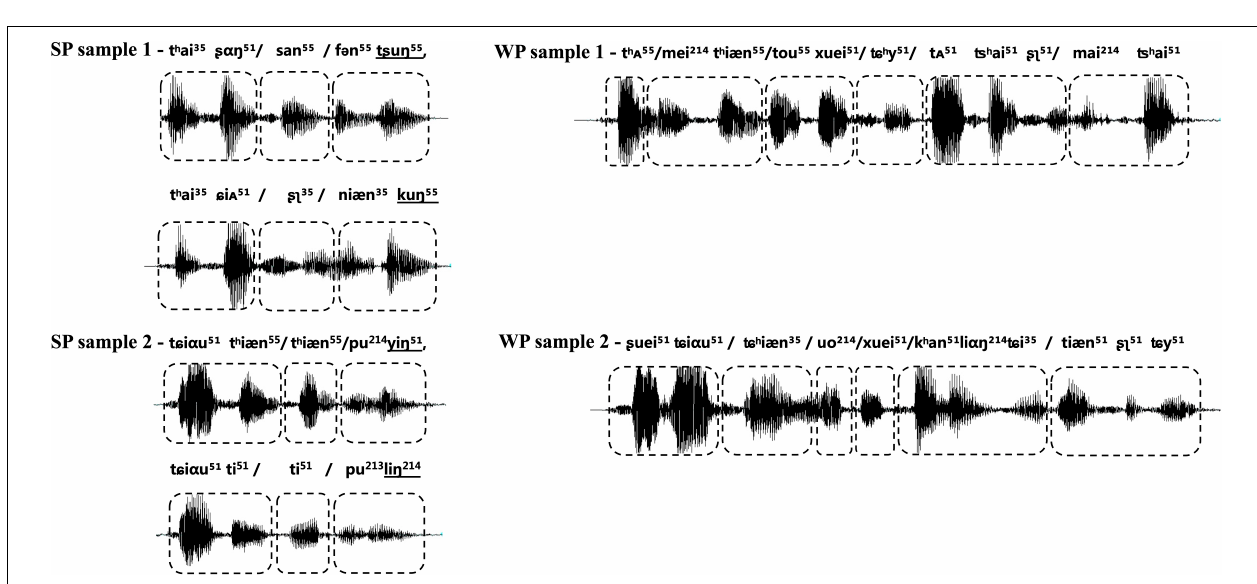
FIGURE 1 | Slow event-related experimental design. One trial lasted 18 s, including 3 s of the auditory stimulus and a 15-s resting period (shown by dark gray brackets). The total procedure includes 40 trials.